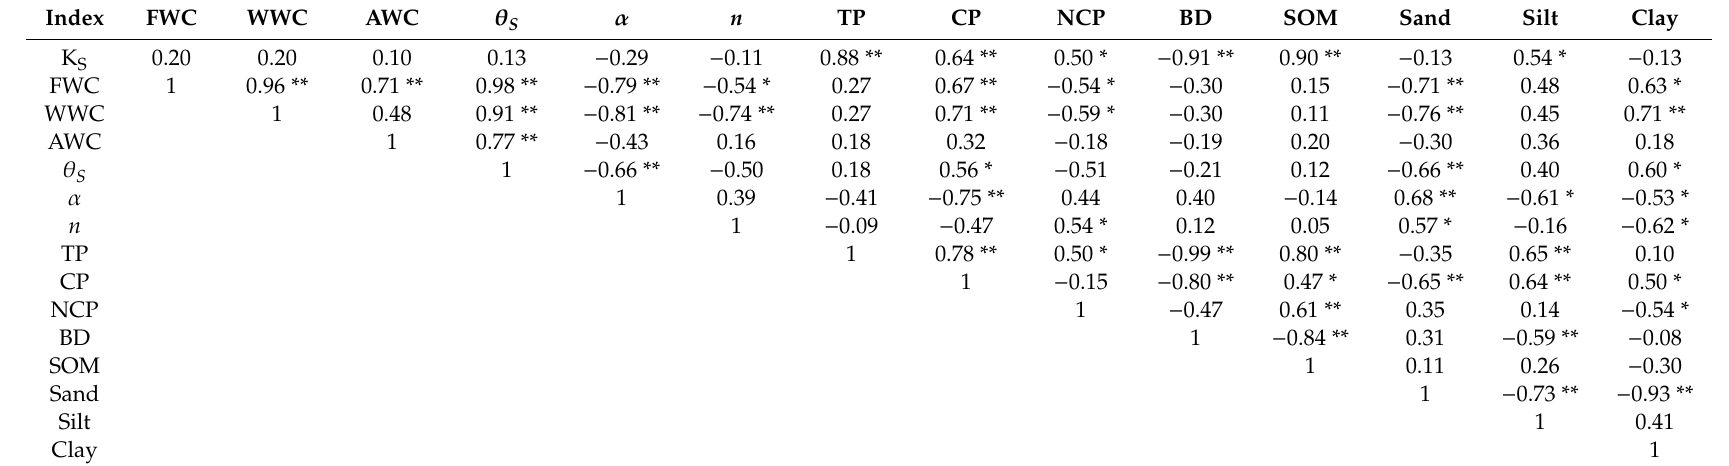
Table 4. Pearson’s correlation coe ffi cients among soil